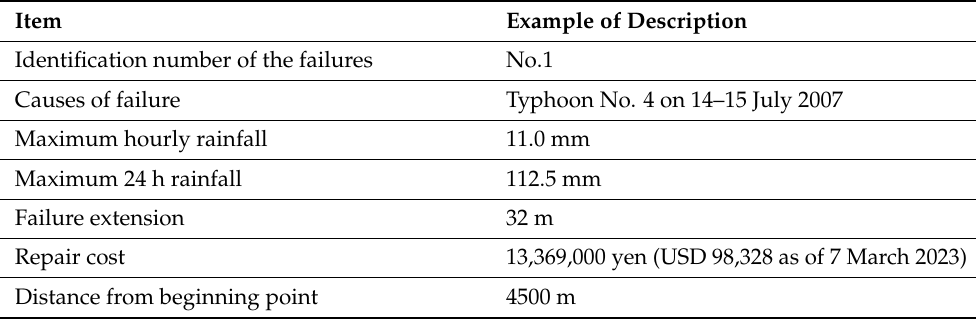
Table 1. Items listed in the Forest Road Facility Failure Assessment Document and examples of how to complete the document.